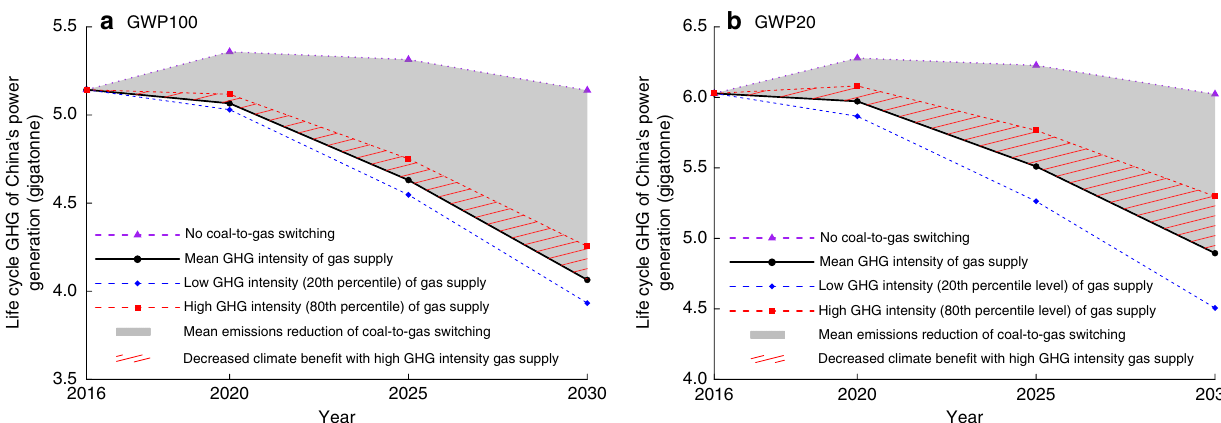
Fig. 5 Estimation of GHG emissions reduction bene fi ts of China ’ s coal-to-gas switching through 2030. a Life cycle GHG emissions of China ’ s power generation through 2030 in GWP 100 . b Life cycle GHG emissions of China ’ s power generation through 2030 in GWP 20 . Different lines in both panels show the projections of life cycle GHG emissions of China ’ s power generation under difference scenarios: 1. No coal-to-gas switching, 2. Mean GHG intensity of gas supply: all growth of natural gas in 2016 – 2030 is assumed to replaced coal in the power sector while maintaining the sum of power output from coal and natural gas the same as that in the no coal-to-gas switching scenario. The well-to-city-gate GHG intensity of natural gas in the scenario is assumed at the mean level at the supply curve. 3. Low GHG intensity of gas supply: assume the same volume of natural gas to replace coal as that in the mean GHG intensity of gas supply scenario. The well-to-city-gate GHG intensity of natural gas in the scenario is assumed at the 20th-percentile level. 4. High GHG intensity of gas supply: assume the same volume of natural gas to replace coal as that in the mean GHG intensity of gas supply scenario. The well-to-city- gate GHG intensity of gas supply in the scenario is assumed at the 80th-percentile level. The projections of China ’ s total electricity generation and other energy sources for power generation through 2030 are obtained from the international energy outlook 2019 by US Energy Information Admiration (EIA) 47 . Life cycle GHG emissions intensity of coal and combustion emissions intensity of natural gas are obtained from a China-data-con fi gured GREET ® 19 . Source data are provided in a Source Data fi le.